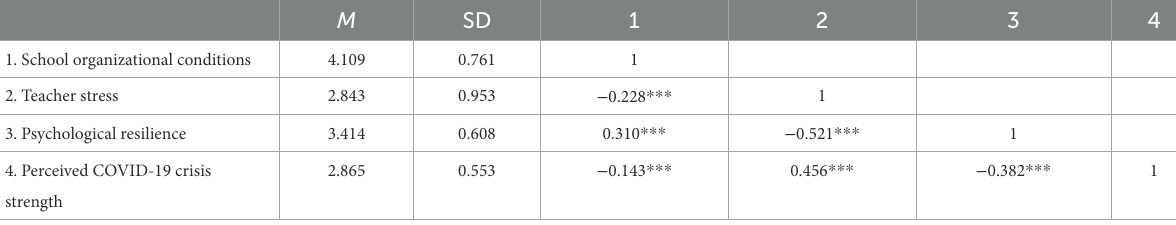
TABLE 4 Descriptive statistics of and correlations among study variables.